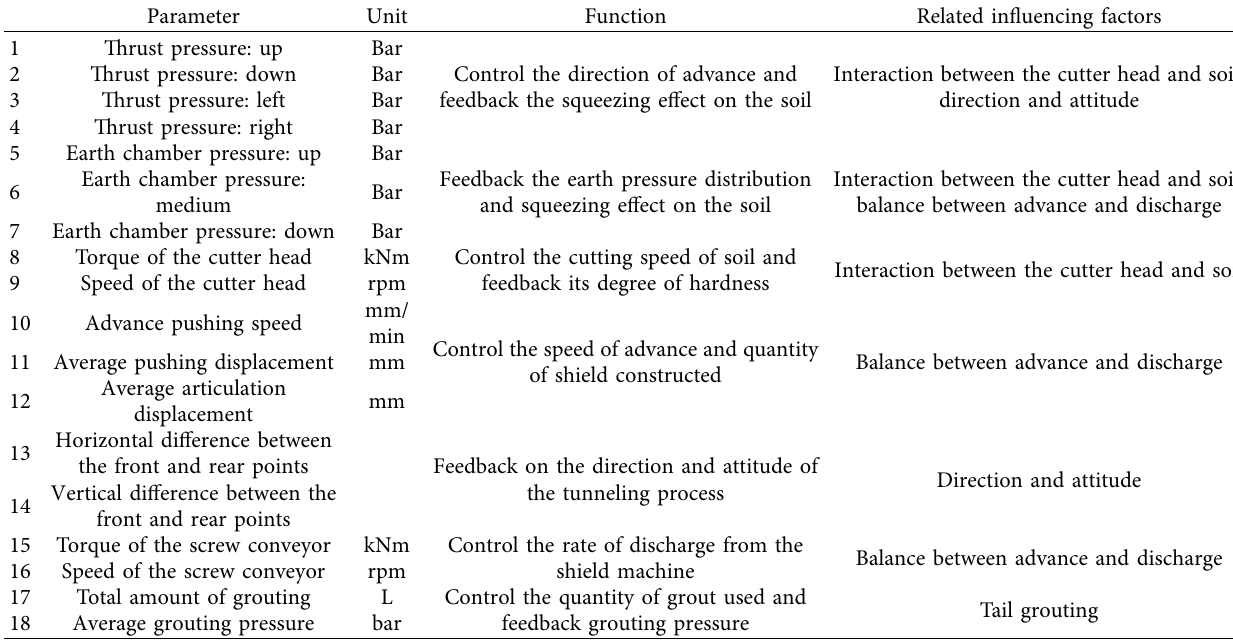
Table 1: Shield construction parameters related to ground